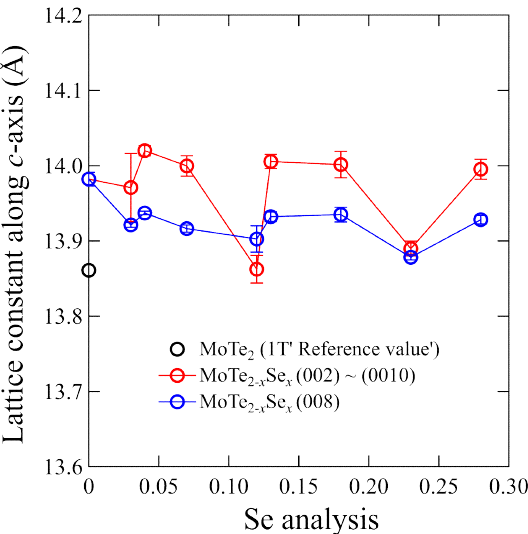
Figure 3. Lattice constants along the c -axis calculated through XRD patterns of the (00 l ) plane for single crystals. Error bars were calculated using five samples from the same batch. The reference value curve corresponds to previously reported results [14].